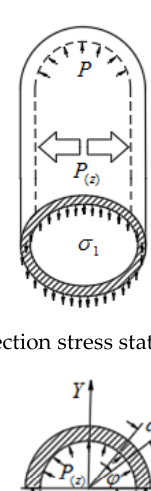
( a ) Growth stress model of jujube bark. ( b ) Cross section stress state of jujube bark.